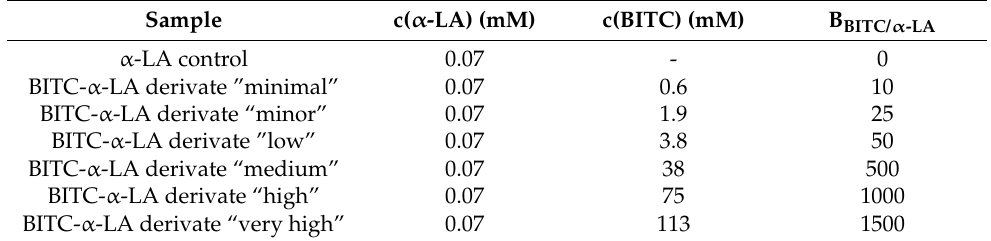
Table 7. Summary of synthesis parameters to represent BITC protein conjugates and control